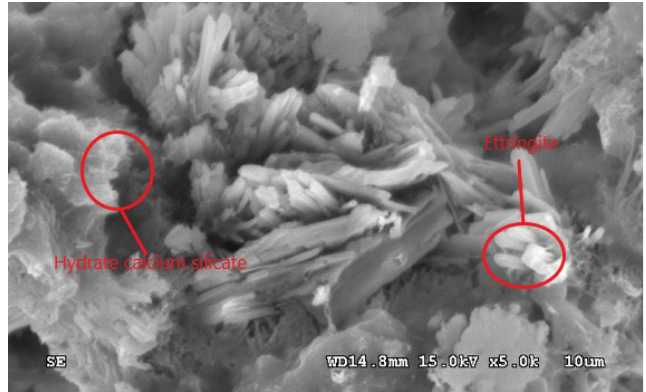
Figure 14. Cement paste SEM in 5000 k image.